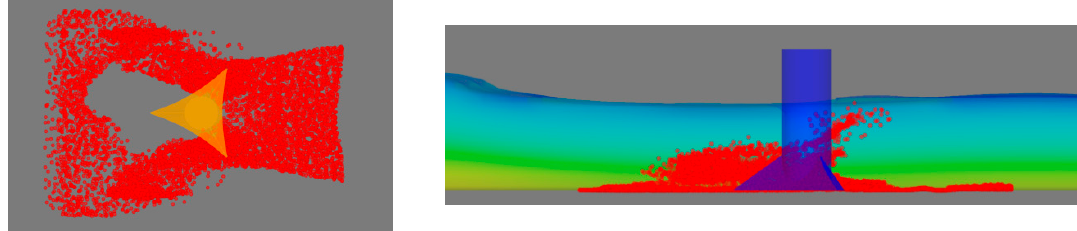
Figure 23. Plan and side view of the bed morphology after exposure to waves for 80s (tripod monopile).